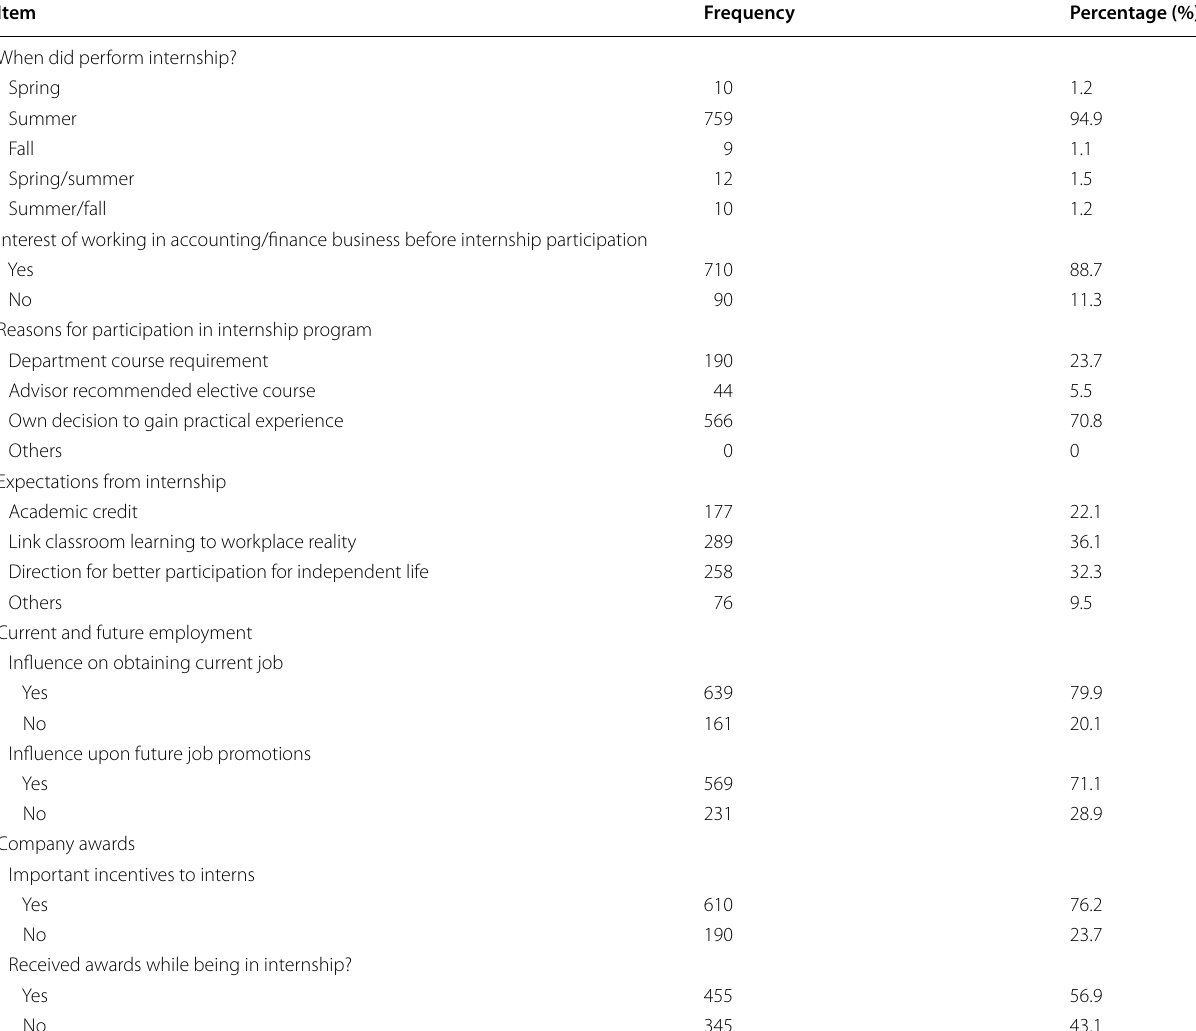
Table 2 Percentage and frequency distribution of reasons for participation in internship Source : developed for the